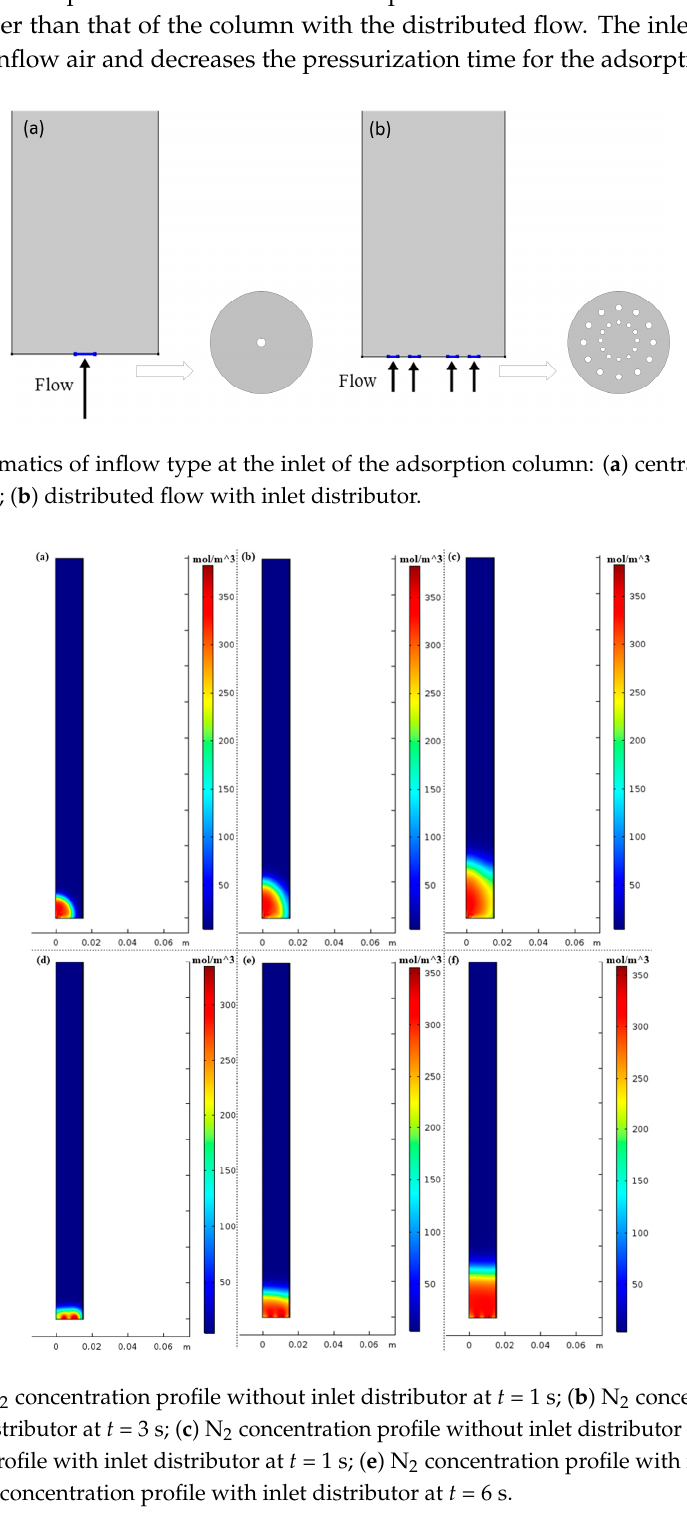
Figure 17. Simulation results of outflow oxygen concentration for different inflow type.